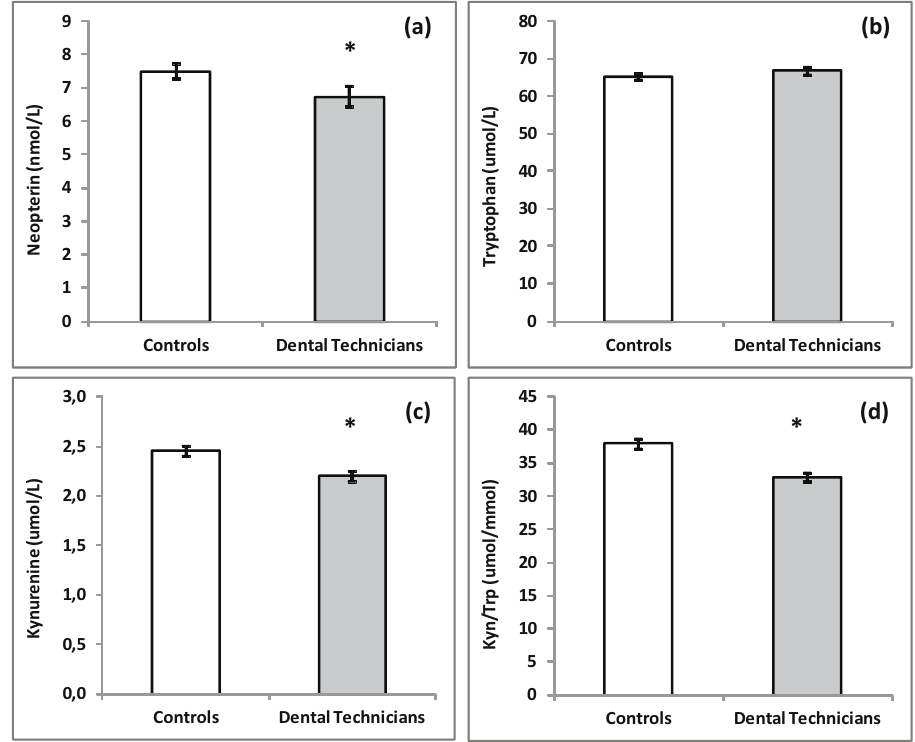
Figure 1: Comparison of neopterin ( a ) , Trp ( b ) , Kyn ( c ) , and Kyn/Trp ( d ) levels between controls and dental technicians. * p < 0.01.